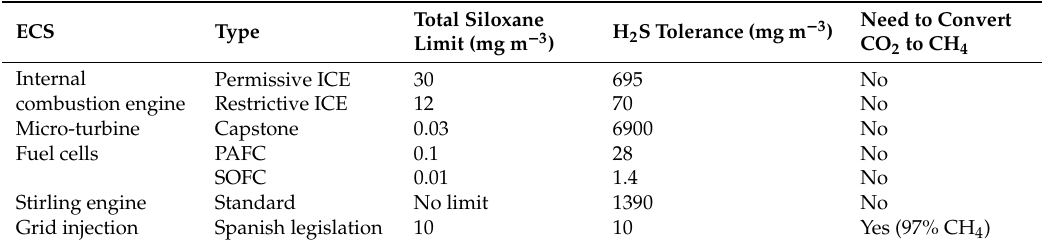
Table 1. Concentration limits of each compounds according to quality requirements of di ff erent energy conversion systems [13,16,22,42,43]. ICE: internal combustion engine; PAFC: phosphoric acid fuel cell; SOFC: solid oxide fuel cell.